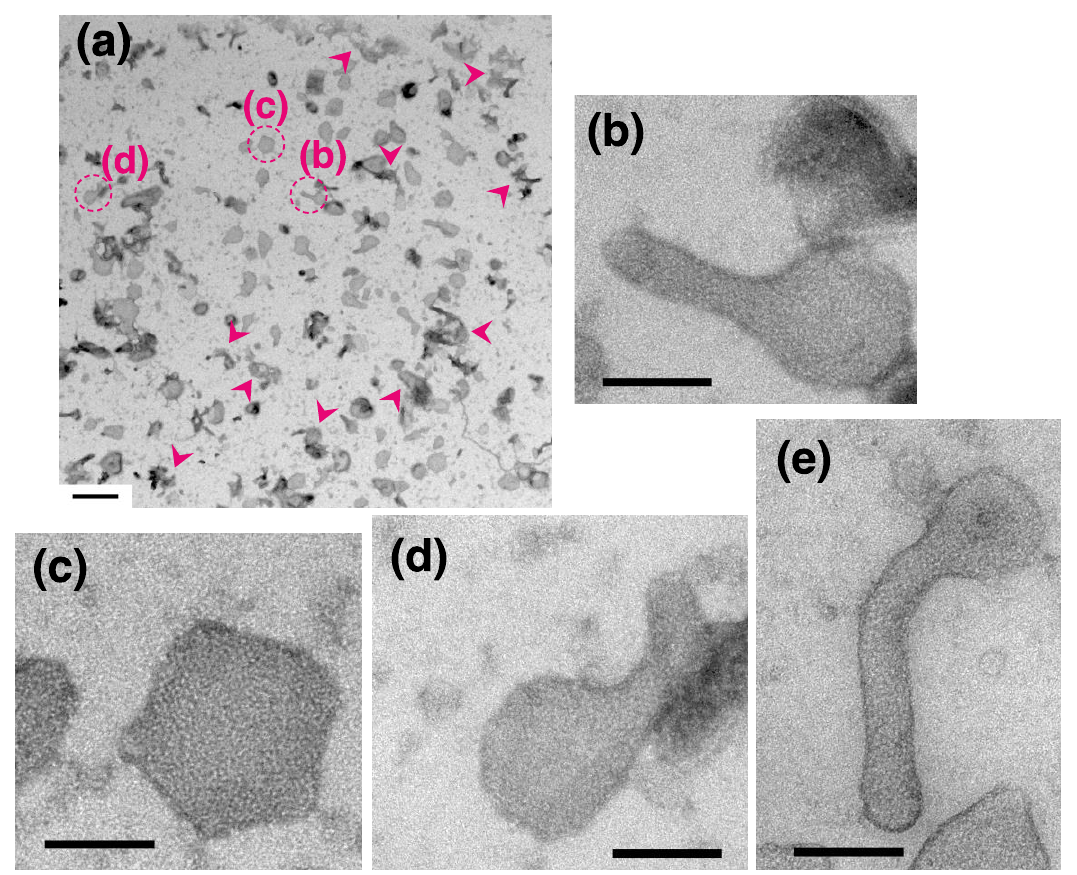
Figure 2. SR vesicles in the presence of ATP and 0.02 nM Ca 2+ at 0 ◦ C. ( a ) Overview showing the SR vesicle population within the 5.4 µ m by 5.4 µ m specimen grid area imaged by TEM. Variously shaped vesicles and agglomerates are present. Some agglomerated vesicles are indicated by arrowheads as a reference. ( b – d ) Higher magnification images of the tightly elongated ( b ), pentagonal ( c ) and crookedly elongated ( d ) vesicles marked with the dotted circles in ( a ). A crystalline array of 40 nM particles is clear in ( b ). ( e ) A crookedly elongated vesicle, not present in overview ( a ). Scale bar in ( a ): 0.5 µ m. Scale bars in ( b – e ): 100